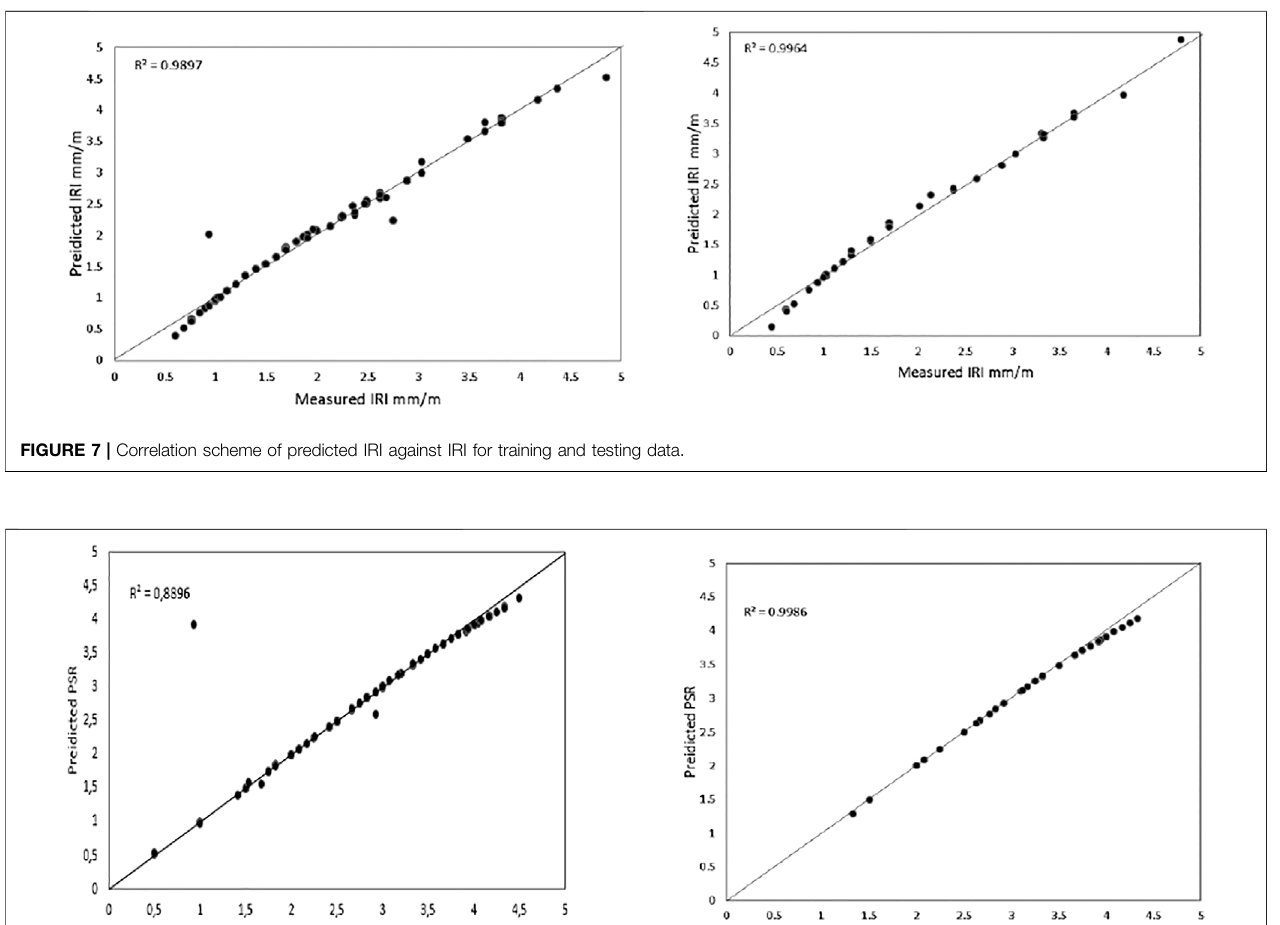
Frontiers in Built Environment |